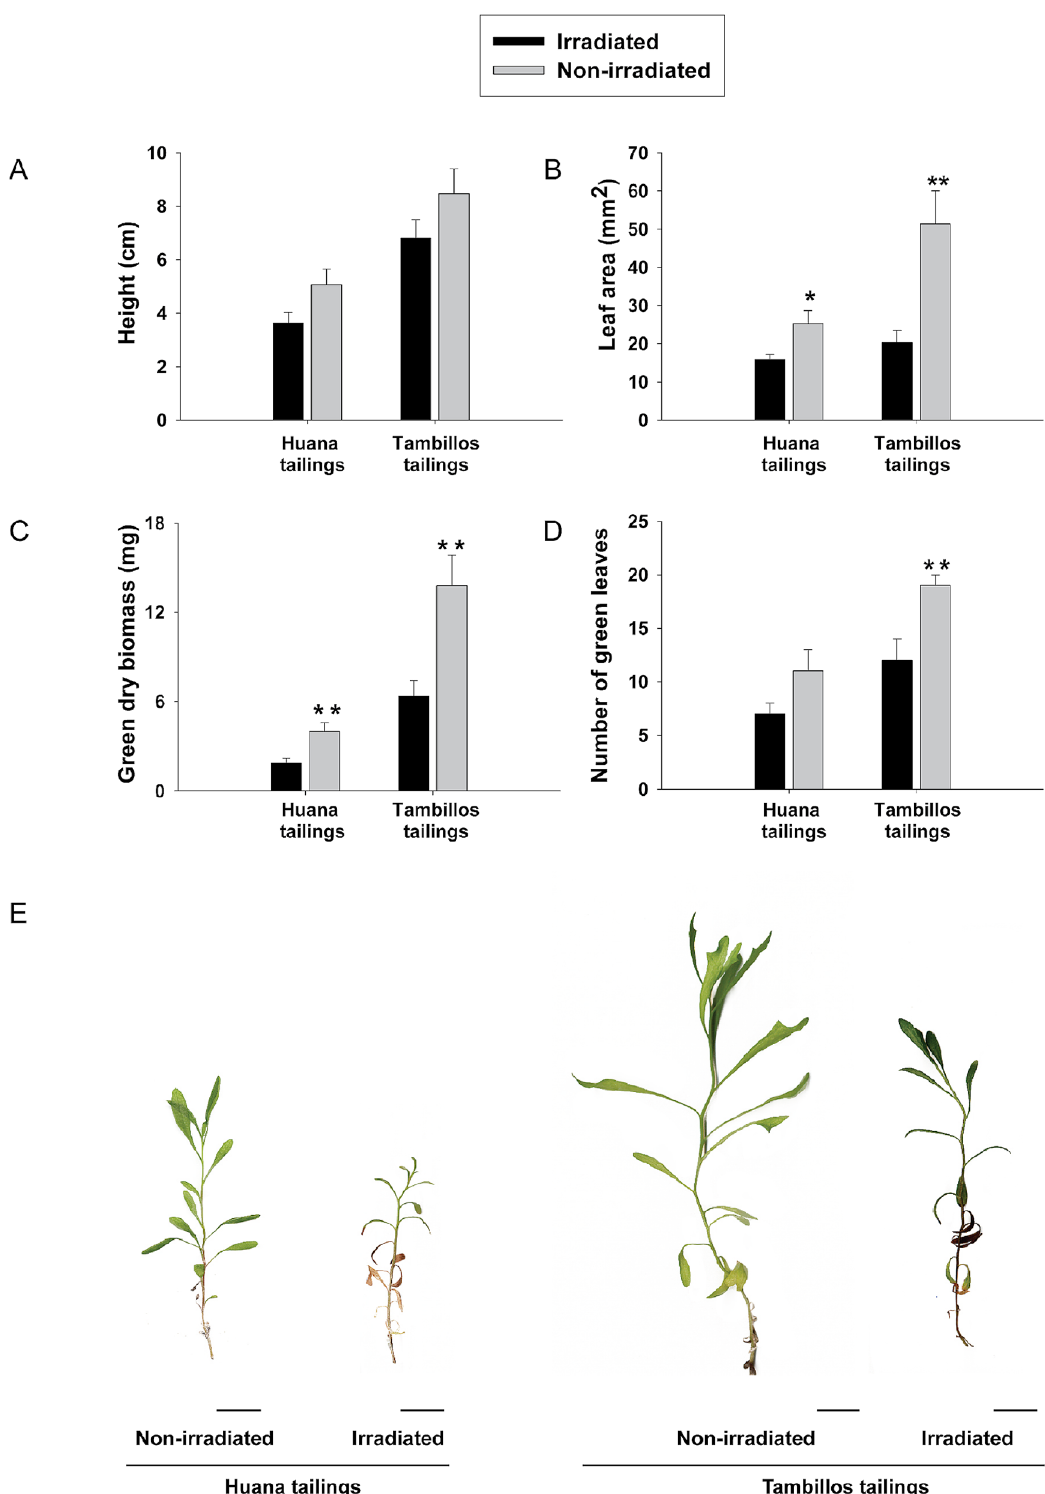
Figure 5. Effects of the microbial community in the establishment of Baccharis linearis plants in non-irradiated or irradiated tailing substrates. Plantlets were transferred to non-irradiated (grey bars) or irradiated (black bars) tailing substrates six weeks after sowing and plant growth parameters (A) height; (B) leaf area; (C) green dry biomass and (D) number of green leaves, were measured 18 weeks after transplantation. Bars represent average ± SE (24 replicates per treatment). Asterisks indicate significant differences according to a one-way ANOVA (for parametric data) or to a Kruskal–Wallis test (for non-parametric data) considering irradiation as factor; *p < 0.05 **p < 0.01. (E) . Representative plants grown on each treatment are shown, bars indicate 1